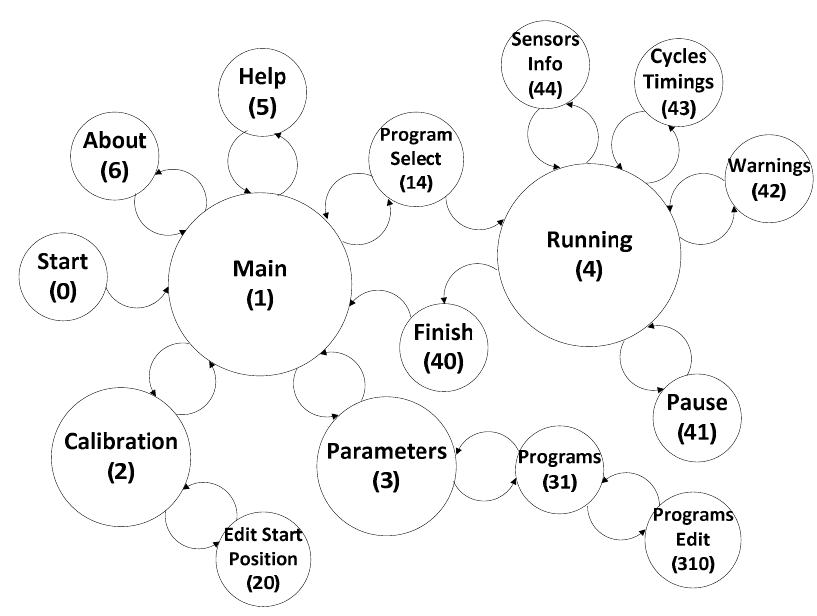
Figure 5. State machine control nodes.